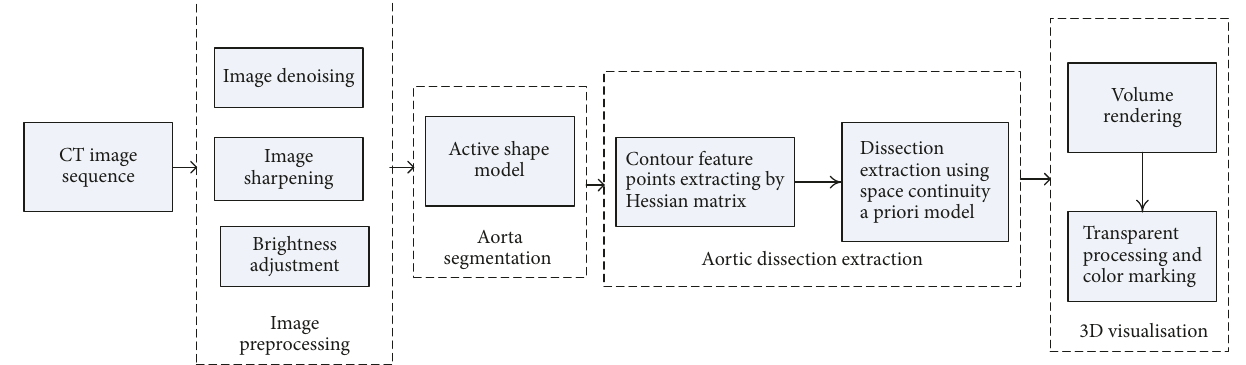
Figure 2: The framework of the three-dimensional reconstruction system.